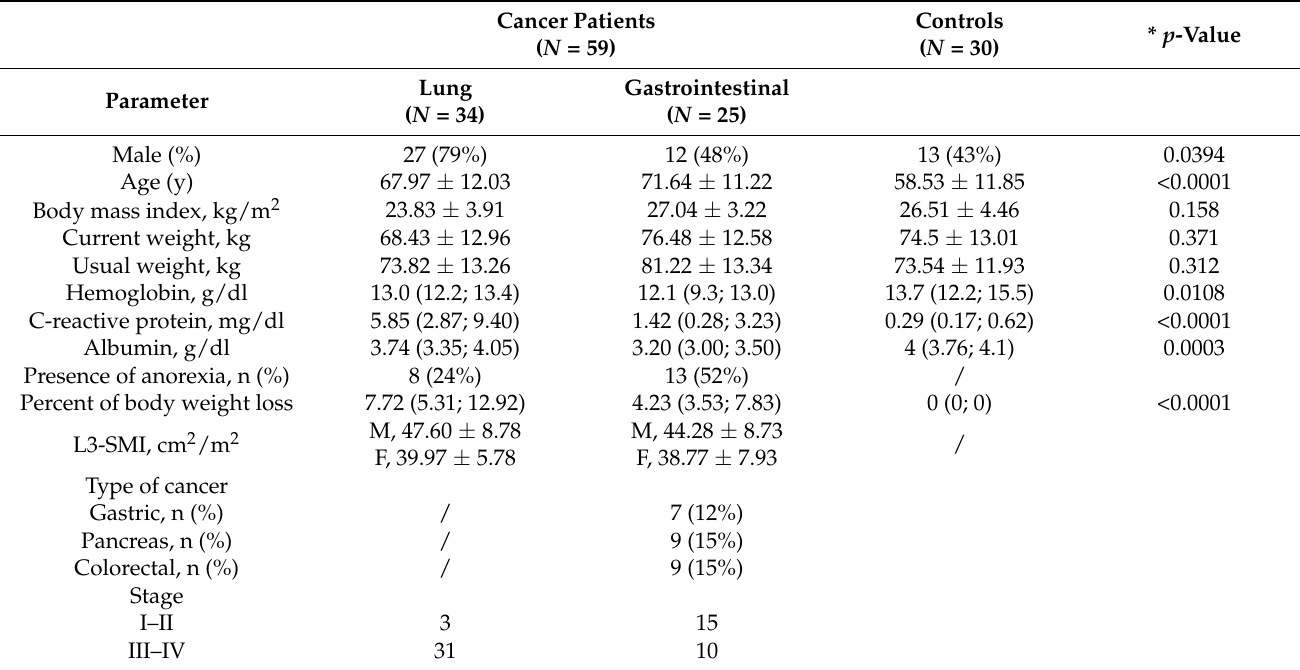
Table 1. Patient’s